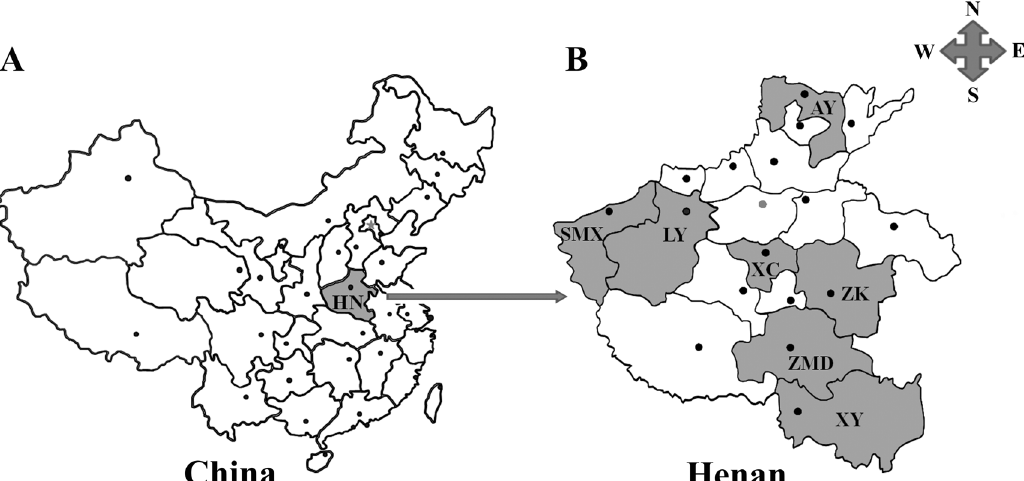
Figure 1. Geographic distribution of the sampling sites in Henan province, central China used in this study. A: Henan province (HN, shadowed areas) is located in the central part of mainland China. B: Shadowed areas are the sampling locations for the present survey.